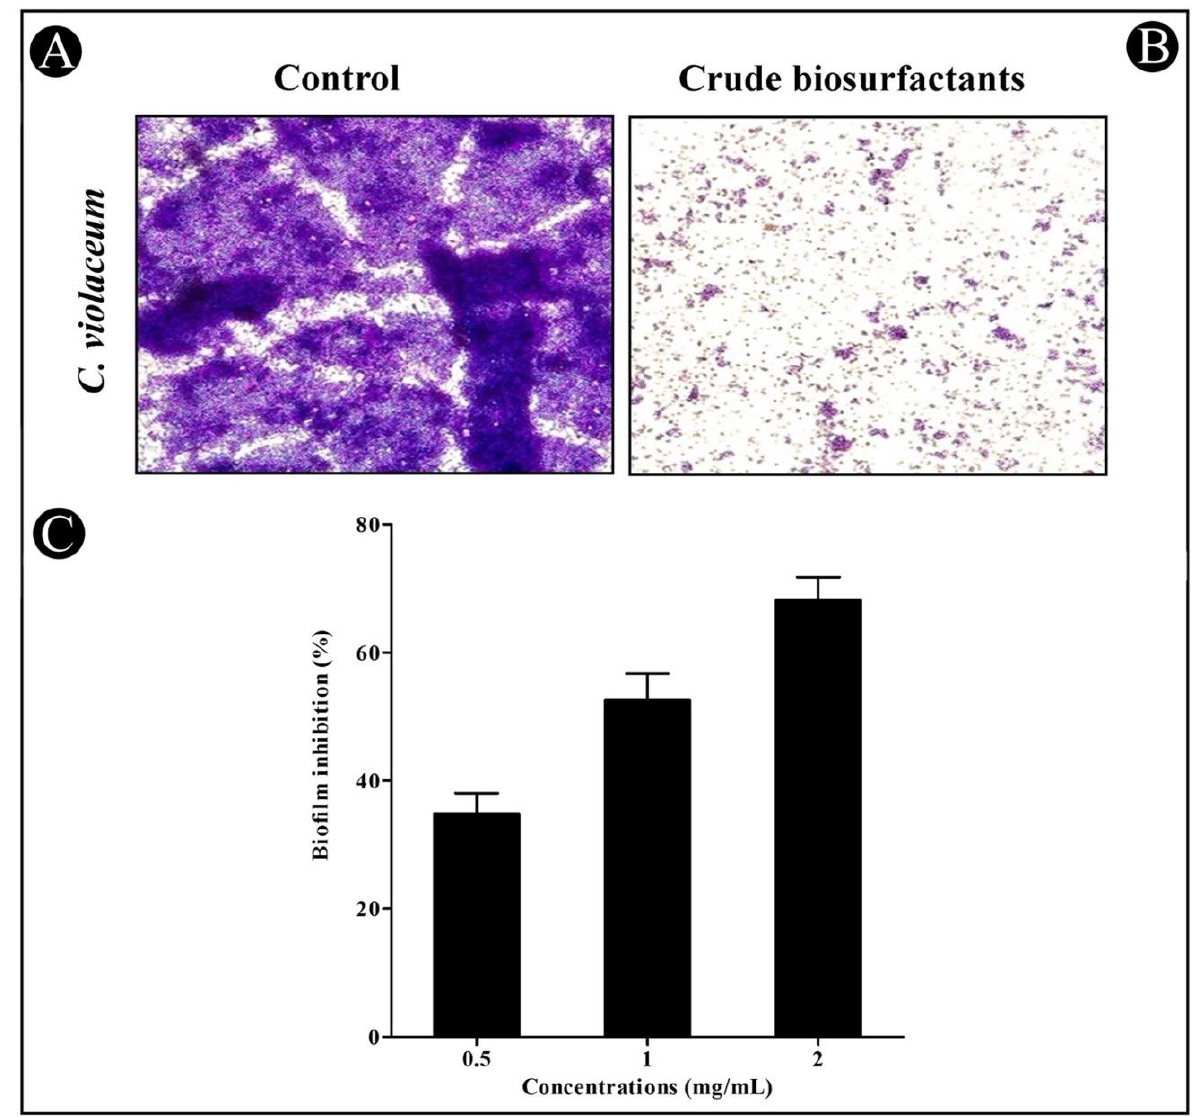
Figure 5. In situ light microscopy analysis of the biofilm inhibition and antibiofilm potential of the crude L. plantarum biosurfactant against C. violaceum . ( A ) The control shows biofilm formation. ( B ) The crude biosurfactant reduced the biofilm matrix at a concentration of 2.5 mg/mL. ( C ) The inhibition of the biofilm was detected by a UV–VIS spectrophotometer and presented as percentage inhibition (with respect to untreated control). Values are represented as mean ± SD of three independent experiments.